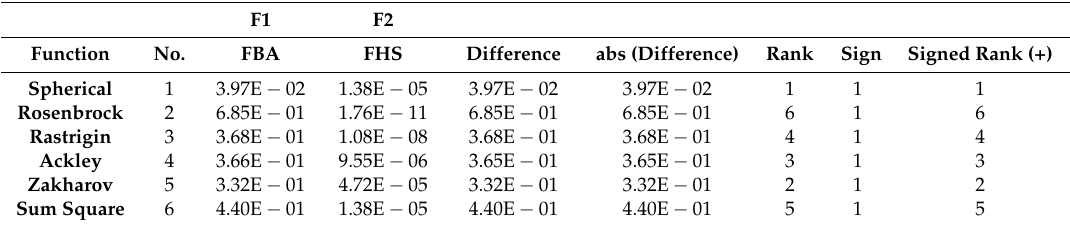
Table 19. Parameters for the Wilcoxon statistical test.